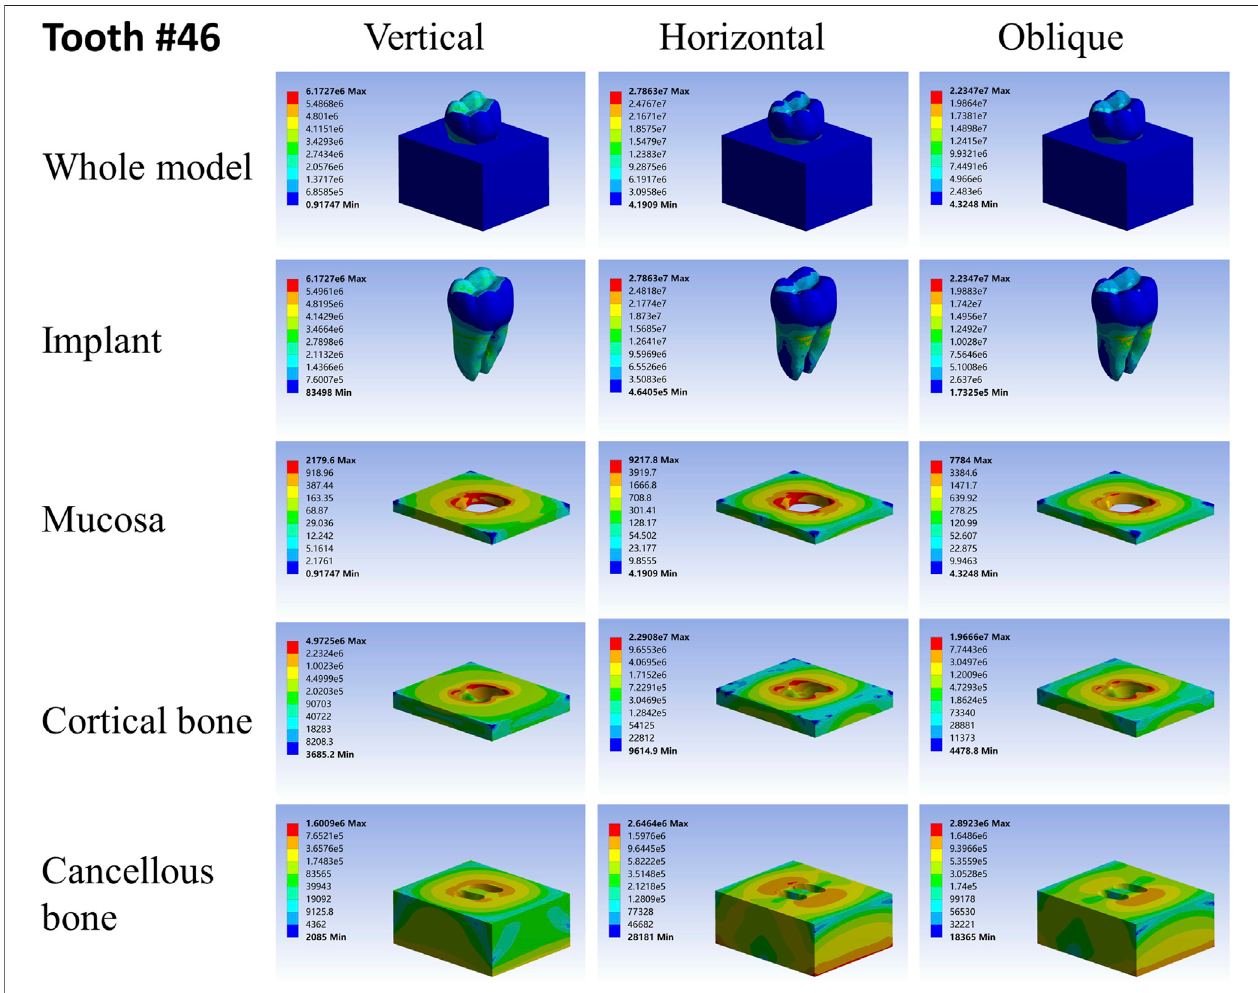
FIGURE 3 | Stress distribution of 46 under 100-N